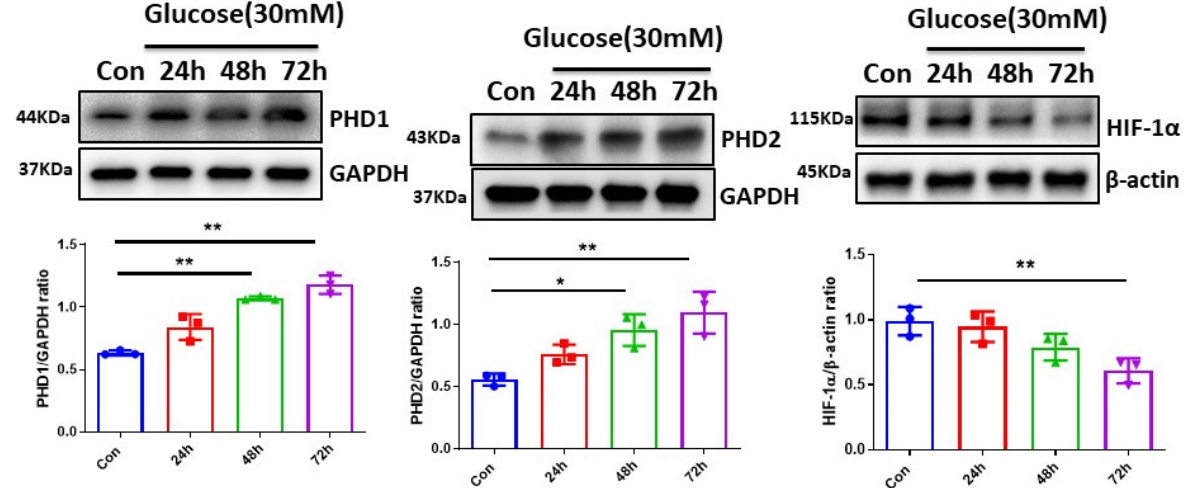
Figure 1. Time course of high-glucose (HG) upregulated PHDs expression and reduced HIF-1 α expression in H9c2 cells. Western blot analysis demonstrating that exposure of H9c2 cells to HG (30 mM) for 24, 48, and 72 h resulted in a gradual increase in expression of PHD1 and PHD2 as compared to control normal glucose (5.5 mM). Densitometries showed a significant upregulation of PHD1 and PHD2 expression at 48 h and 72 h. Exposure of H9c2 cells to HG (30 mM) for 24, 48, and 72 h resulted in a gradual reduction in HIF-1 α expression as compared to control normal glucose (5.5 mM). Densitometries showed a significant downregulation of HIF-1 α expression at 72 h. All data represent mean ± SD (n = 3 per group, * p < 0.05 and ** p < 0.01). Circle, square and triangle were denoted the different experiment groups as indicated in the figures.